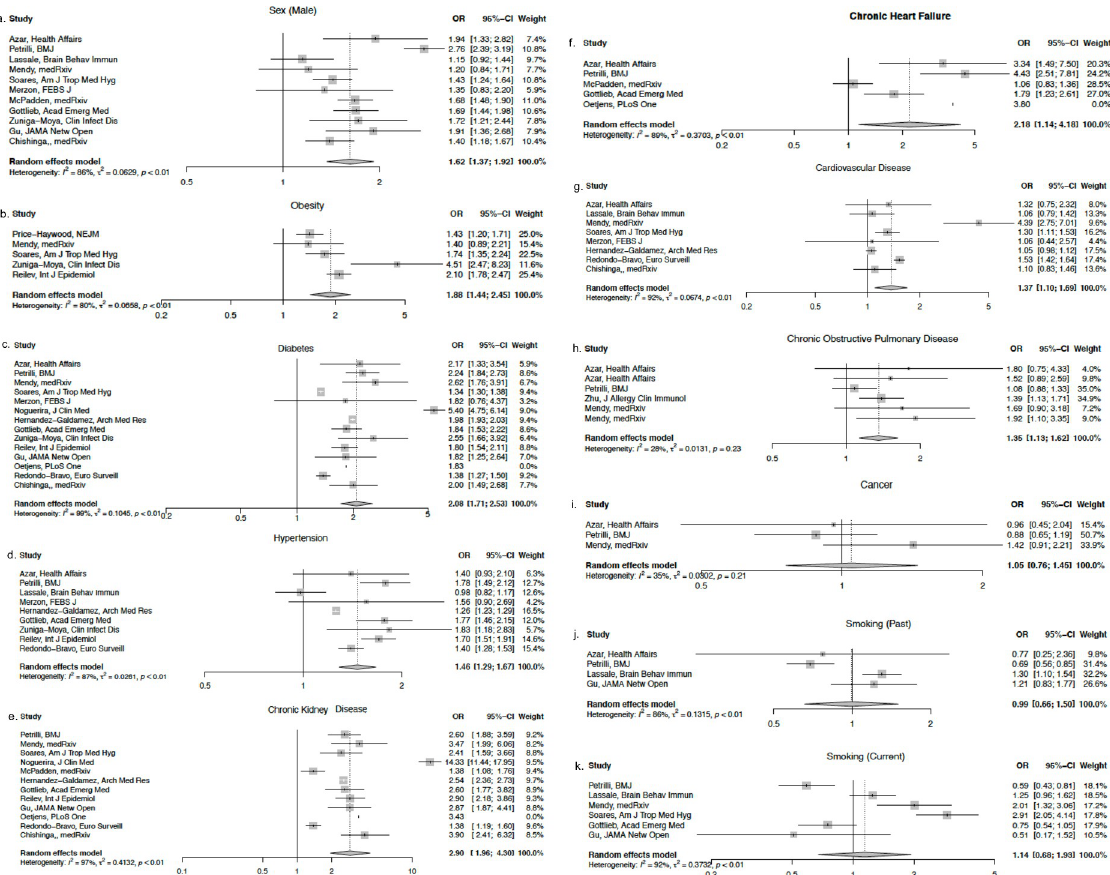
Fig 5. a-k. Forest plots for individual study estimates and pooled estimates of risk factors associated with COVID-19 related